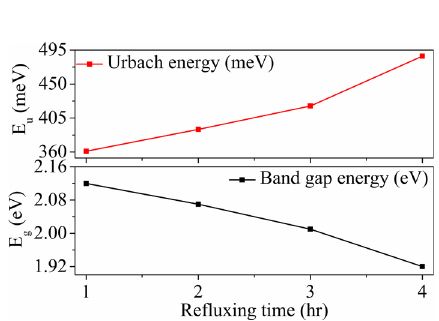
and E variation g u